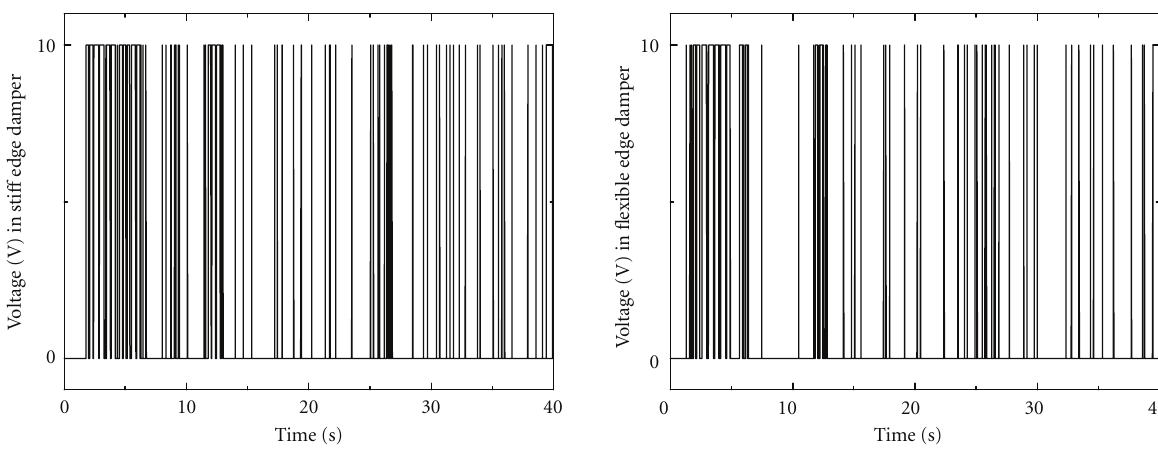
Figure 9: Time variation of applied voltage for dampers located at sti ff and flexible edges for semiactive clipped-optimal control under Imperial Valley, 1940 earthquake ( T y = 1s, Ω θ = 1, e x / r = 0 .